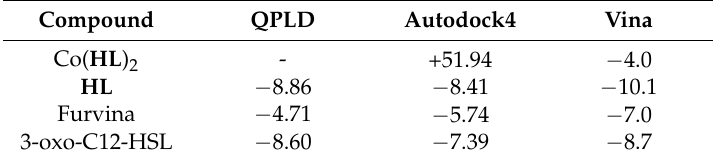
Table 2. Docking interaction scores (kcal/mol) with transcriptional activator protein LasR. Compound QPLD